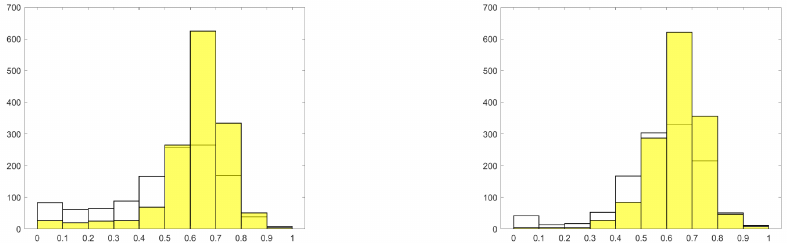
Figure 21. Two histograms corresponding to the values of two pixels located in the top left corner. Each histogram characterizes the distribution of the training samples with respect to class “malignant” (yellow bars) and class “benign” (white